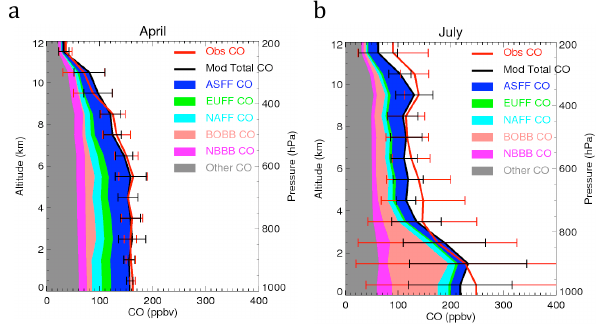
Figure 2. Vertical distribution of the DC-­‐8 measurements and Fig. 2. Vertical distribution of the CO volume mixing ratio (ppbv) the GEOS-­‐5 simulation when the GEOS-­‐ sampled by all flights for April (2a) and 5 model results are July (2b). The DC-­‐8 CO from along the flight tracks is shown by the solid thick red line with standard from DC-8 measurements and the GEOS-5 simulation when the deviation shown by horizontal bars. GEOS-­‐5 CO is shown by the thick black line for total and by the GEOS-5 model results are sampled by all flights for April (a) and color shaded areas for the corresponding tagged components. The ‘Other CO’ refers to the global CO other than the five tagged COs defined in Figure 1a and it is mostly attributed to the CO chemical July (b) . The DC-8 CO from along the flight tracks is shown by formation from methane oxidation. CO volume mixing ratio (ppbv) from the solid thick red line with standard deviation shown by horizontal bars. GEOS-5 CO is shown by the thick black line for total and by the color-shaded areas for the corresponding tagged components. The “Other CO” refers to the global CO other than the five tagged COs defined in Fig. 1a and it is mostly attributed to the CO chemical formation from methane oxidation.